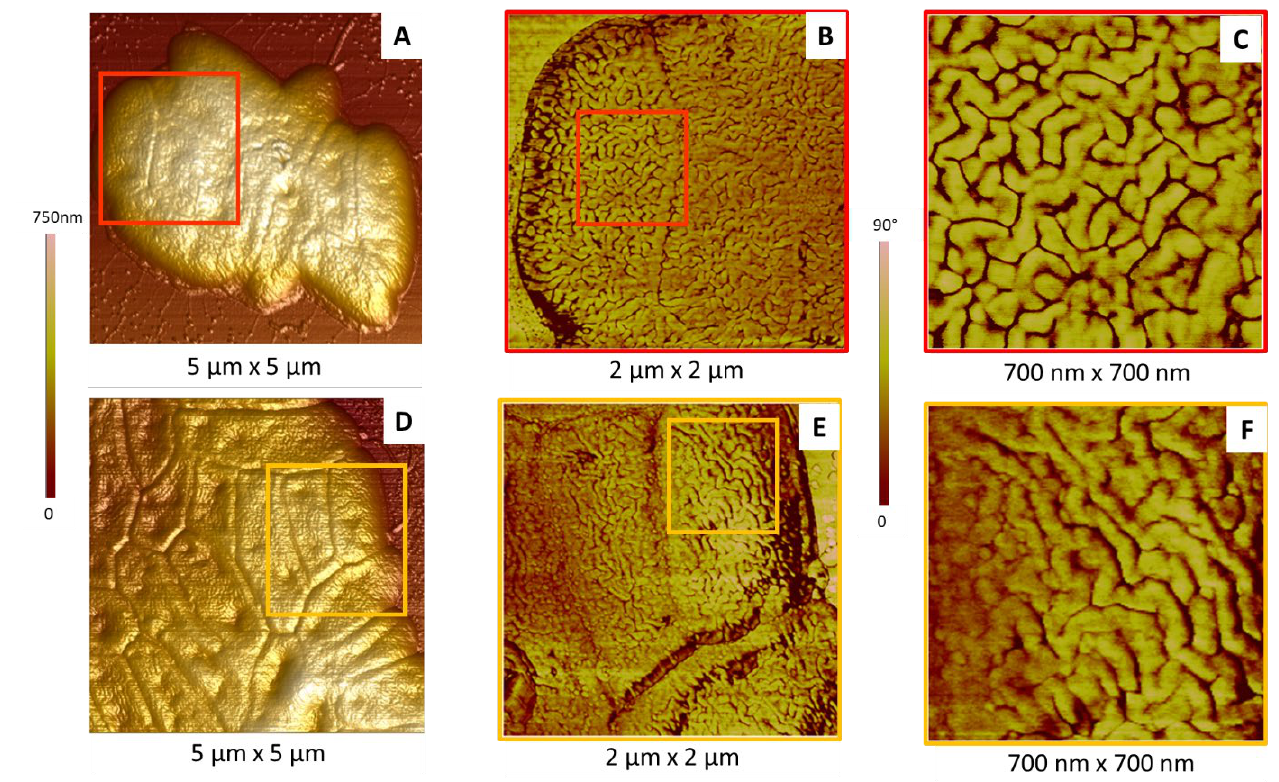
Figure 5. Membrane characteristics of P. fluorescens cells. ( A , D ) The 3D topographic AFM images of aggregated cells; ( B , E ) phase AFM images of areas in the red and orange squares in images ( A ) and ( D ), respectively; ( C , F ) phase AFM images of areas in the red and orange squares in images ( B ) and ( E ), respectively.